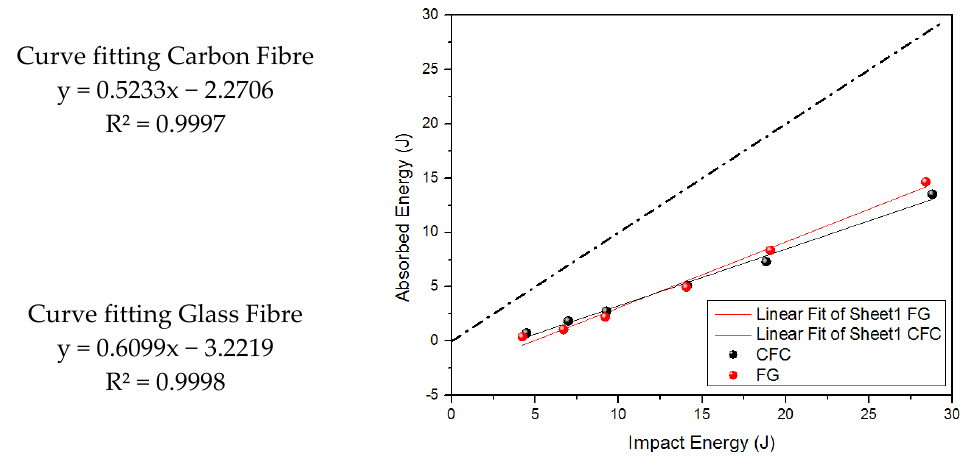
Figure 6. Energy profile with the equal energy curve.